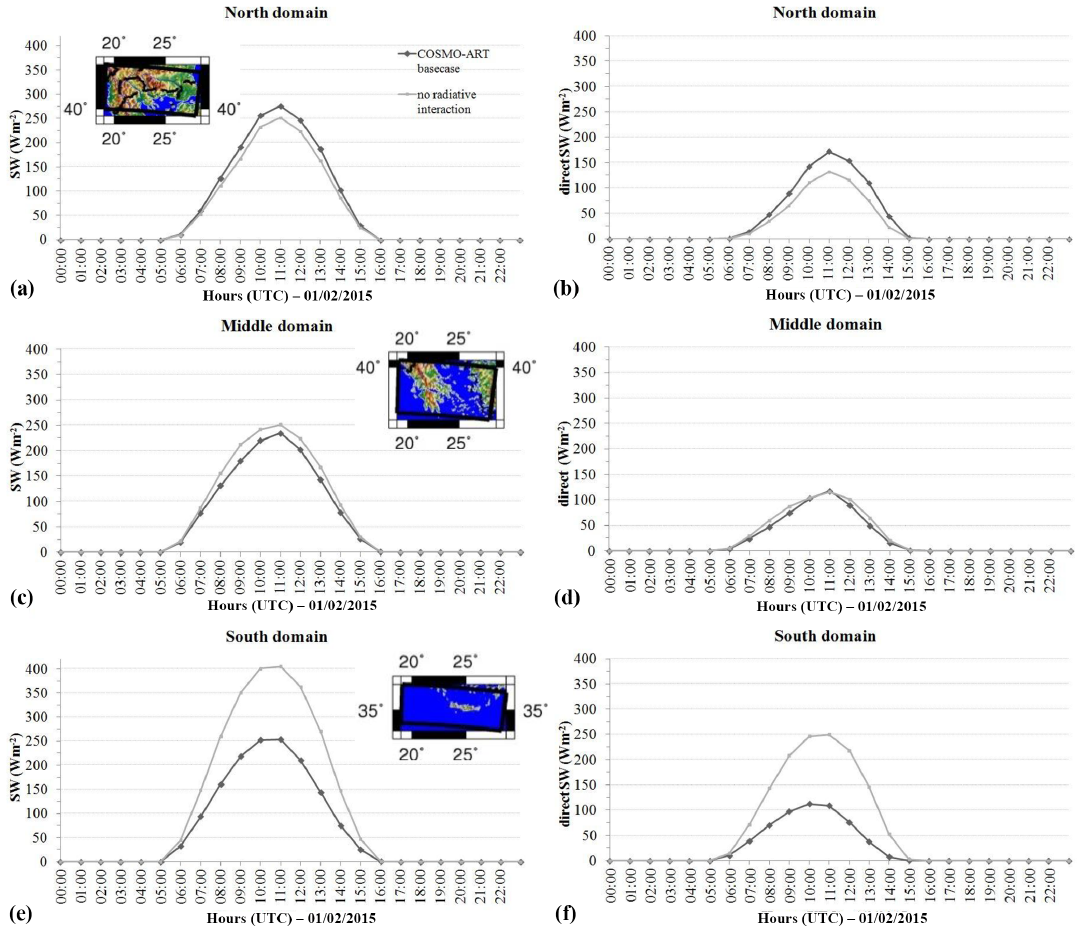
Figure 12. The diurnal variation of the GHI (a, c, e) and DNI (b, d, f) shortwave radiation zonally averaged over the northern, middle and southern domains (maps shown). The dark grey line corresponds to the base-case COSMO-ART run that includes aerosol–meteorology. The light grey line corresponds to the scenario when aerosol–meteorology interaction is switched